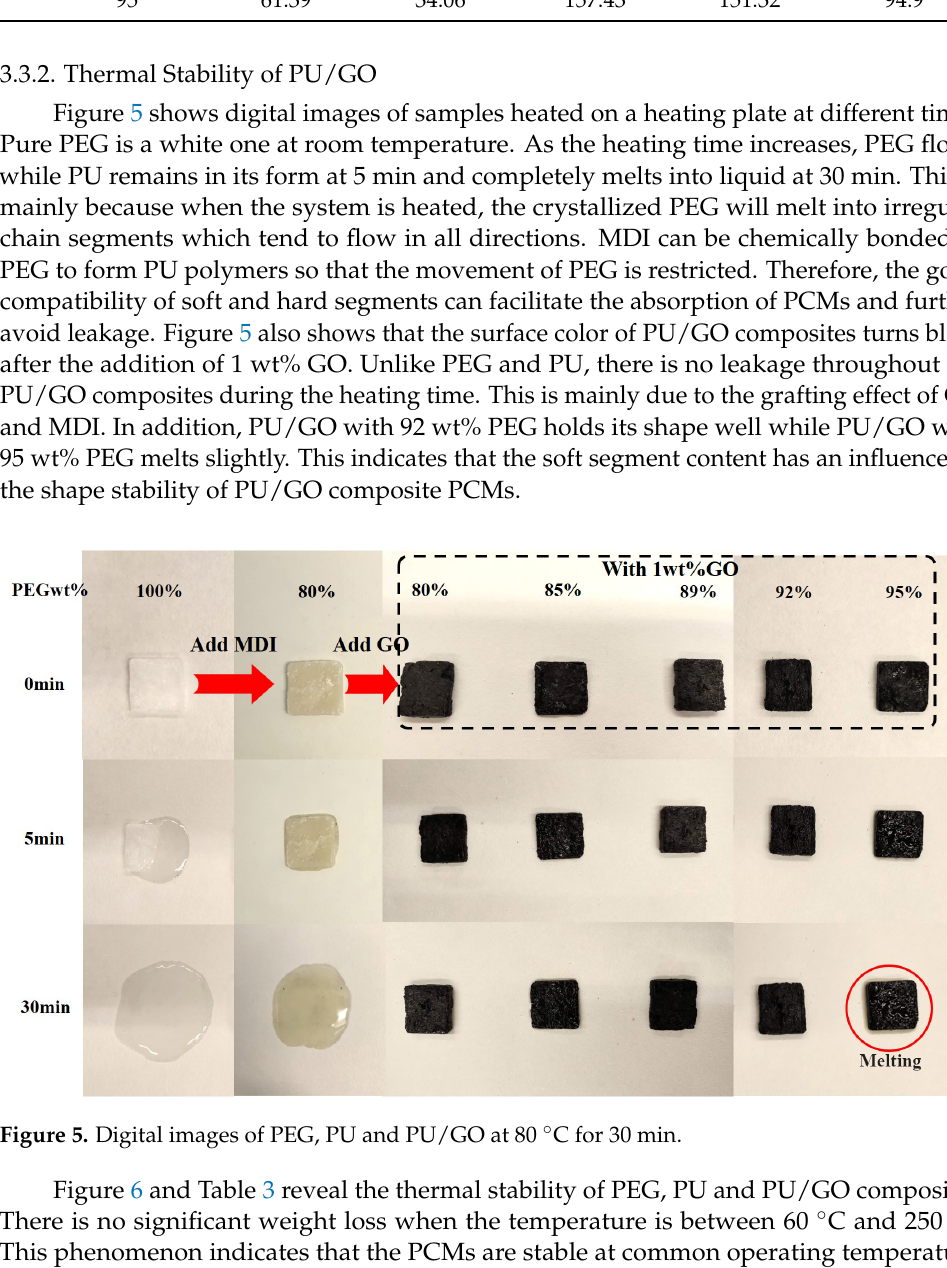
Table 3. DSC data of PEG, PU and PU/GO.